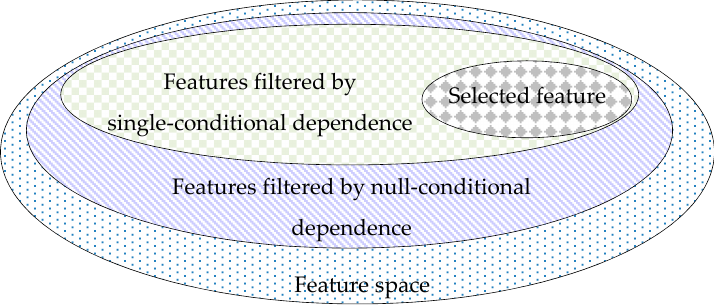
Figure 1. A feature stream with a fixed data stream.